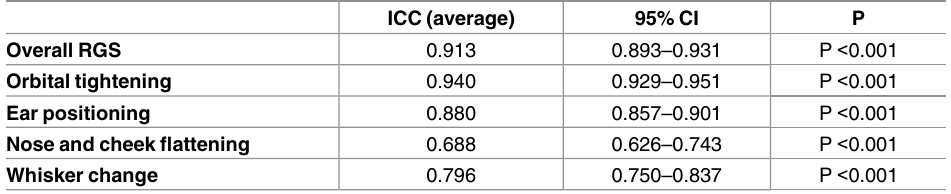
Table 7. Inter-rater reliability for the Rat Grimace Scale (2 nd phase of the